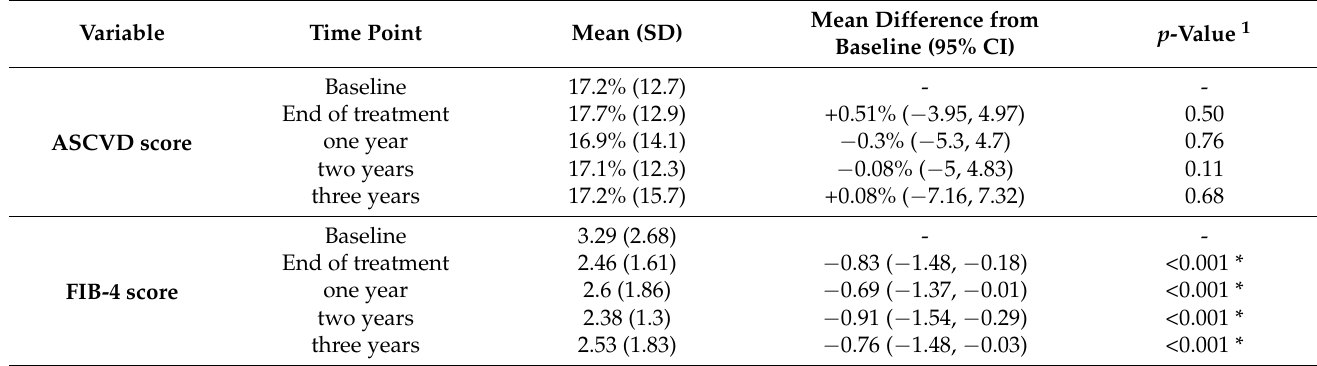
Table 3. Changes from baseline in ASCVD and FIB-4 scores.